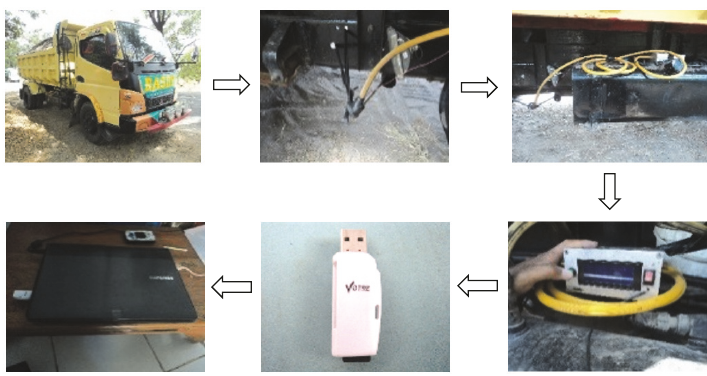
Figure 2: Stages of truck emissions measurement.